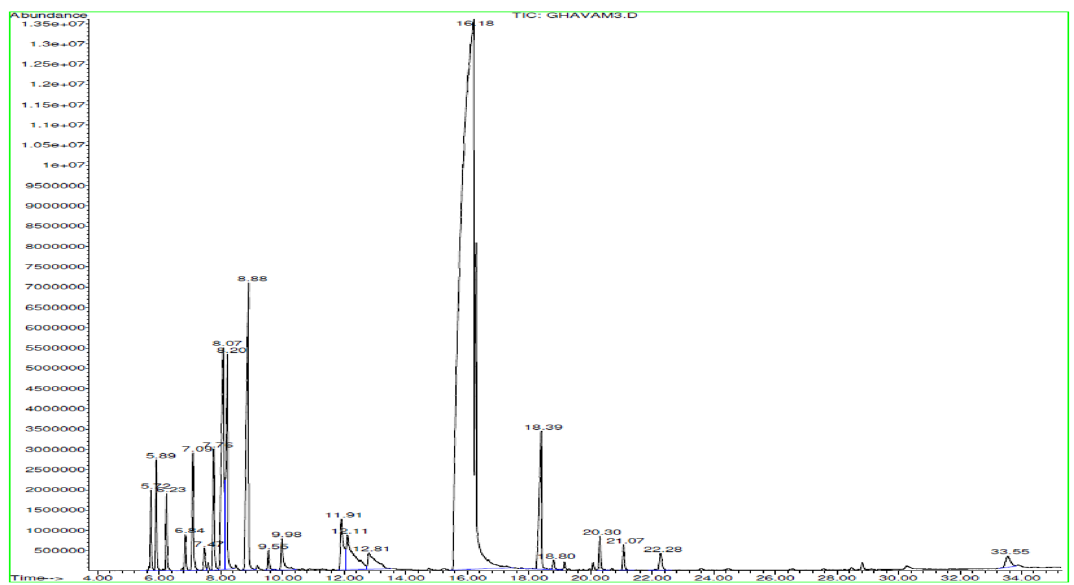
Figure 1. GC–MS chromatogram of essential oil obtained from Thymus daenensis.